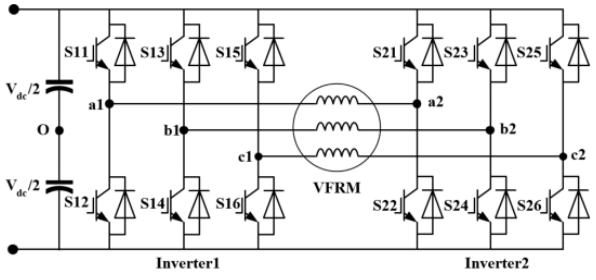
Figure 1. Topology of 6/4 VFRM.